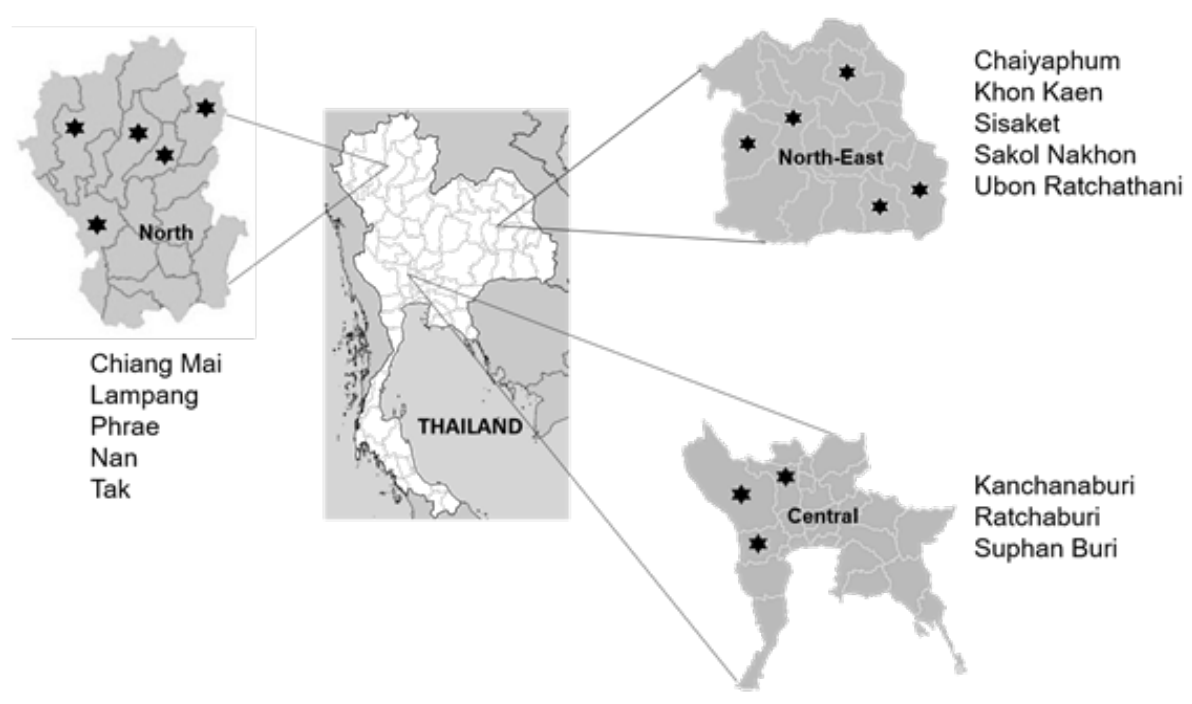
Figure 1: Geographical map of Thailand showing the surveyed